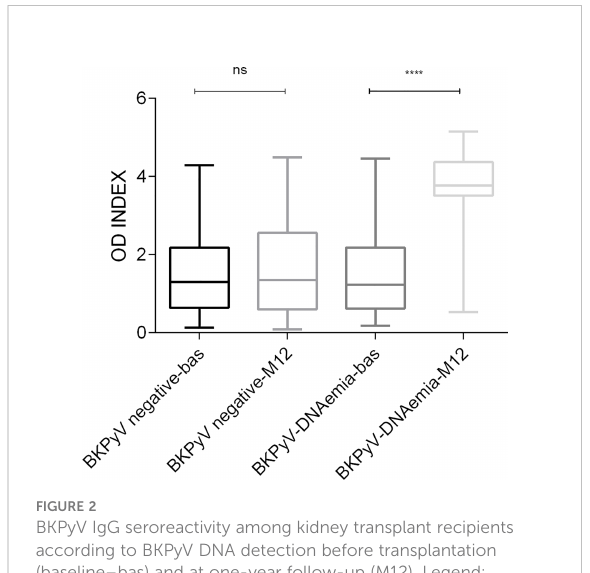
FIGURE 2 BKPyV IgG seroreactivity among kidney transplant recipients according to BKPyV DNA detection before transplantation (baseline – bas) and at one-year follow-up (M12). Legend: ****p < 0.0001, ns non-signi fi cant difference p=0.623, OD INDEX — the ratio of the absorbance of a sample to the respective CO value. bas — baseline, before transplantation; M12 — month 12 after